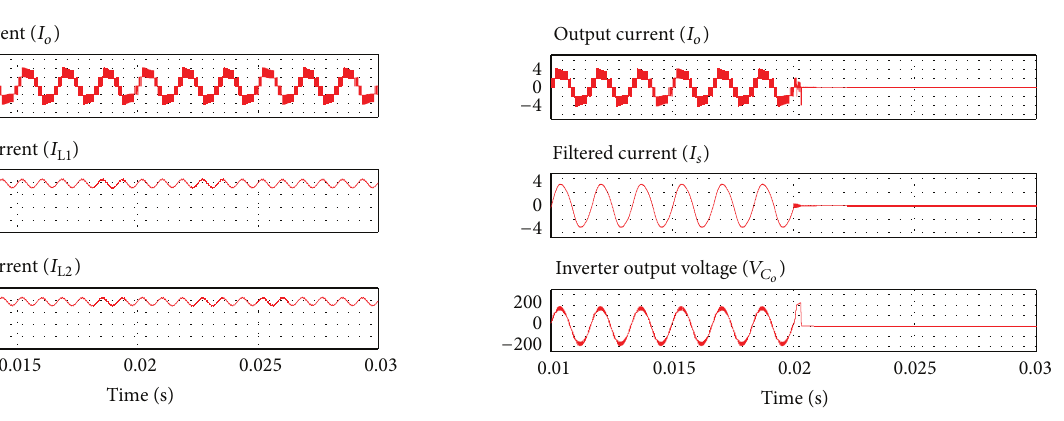
Figure 12: Operation of the system under a grid disconnection with the protection circuit. Top to bottom: output current ( 𝐼 𝑜 , 2 A/div), Filtered current ( 𝐼 𝑠 , 2 A/div), and inverter output voltage , ( 𝑉 𝐶 𝑜